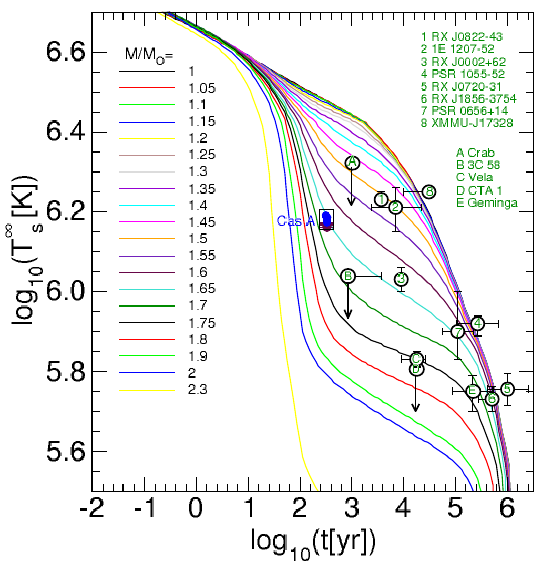
Figure 11. Figure from H. Grigorian calculations with MKVOR EoS [87]. T ∞ s is the redshifted surface temperature, t is the neutron star age. The effective pion gap is given by the solid curve 1a + 1b in Figure 9. The pairing 1 S 0 gaps correspond to calculations with the EEHO model. The mass range is shown in the